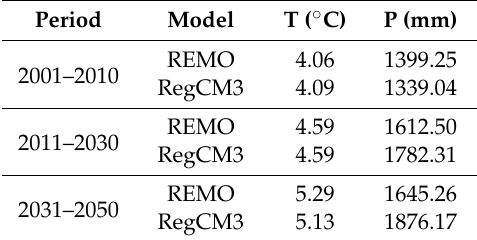
Table 2. Mean temperature (T), and mean annual precipitation (P) simulated by the REMO and RegCM3 climate models for periods 2001–2010, 2010–2030, and